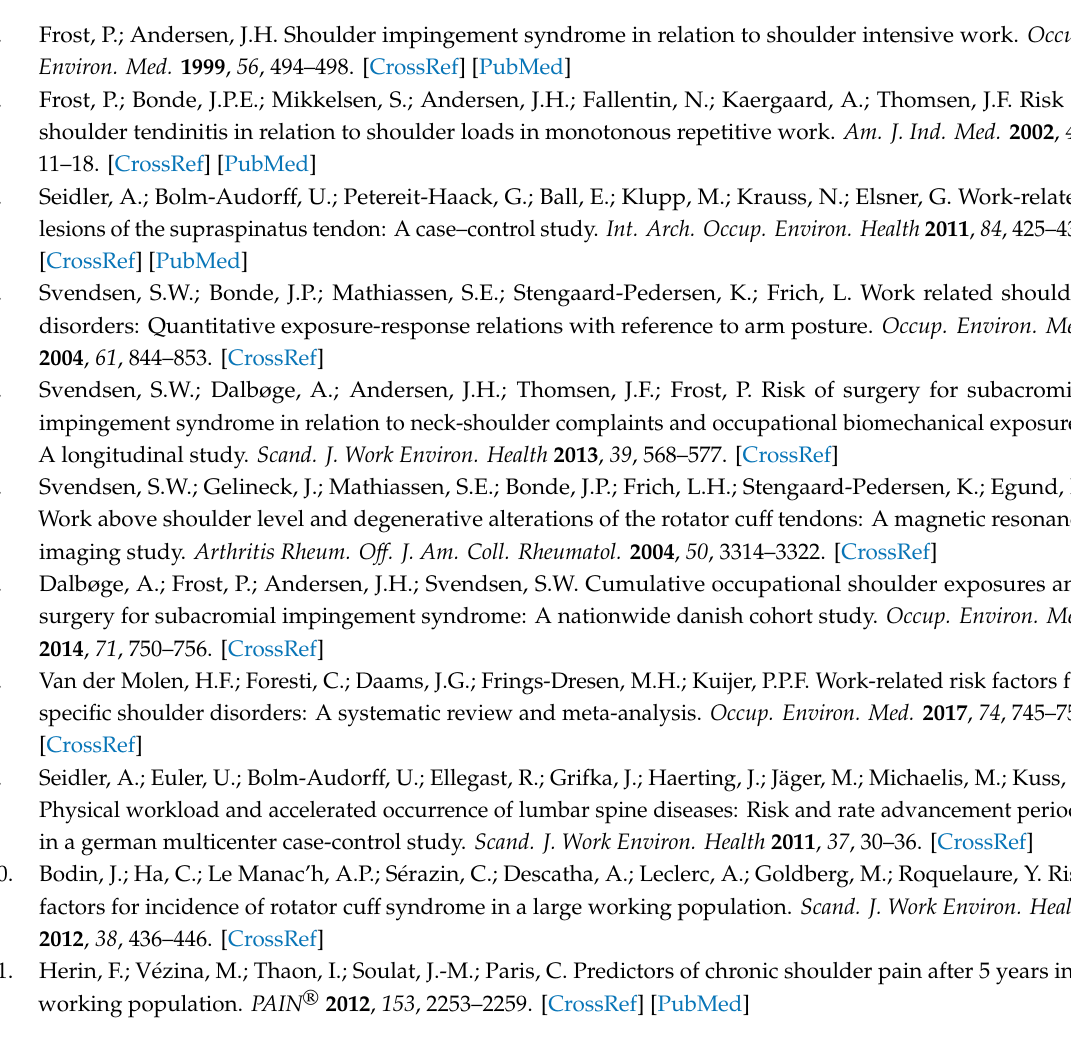
Table S1: Reasons for exclusion of studies. Table S2: Above-shoulder work sensitivity analyses. Figure S1: Forest plot of shoulder disease risk due to work above shoulder level (sensitivity analysis 1). Figure S2: Forest plot of shoulder disease risk due to work above shoulder level (sensitivity analysis 2). Figure S3: Forest plot of shoulder disease risk due to work above shoulder level (sensitivity analysis